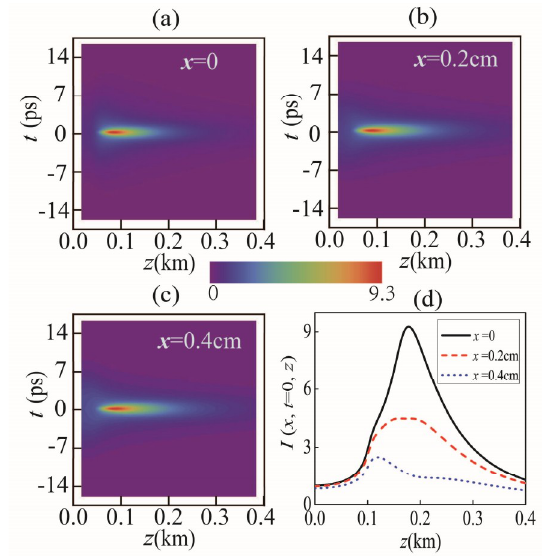
Figure 3. Evolution of normalized spatial-temporal intensity I ( x , t , z ) of PCP beams with rect weight function with different values of x : ( a ) x = 0, ( b ) x = 0.2 cm and ( c ) x = 0.4 cm in the t - z plane. ( d ) Normalized spatial-temporal intensity versus propagation distance z with t = 0.